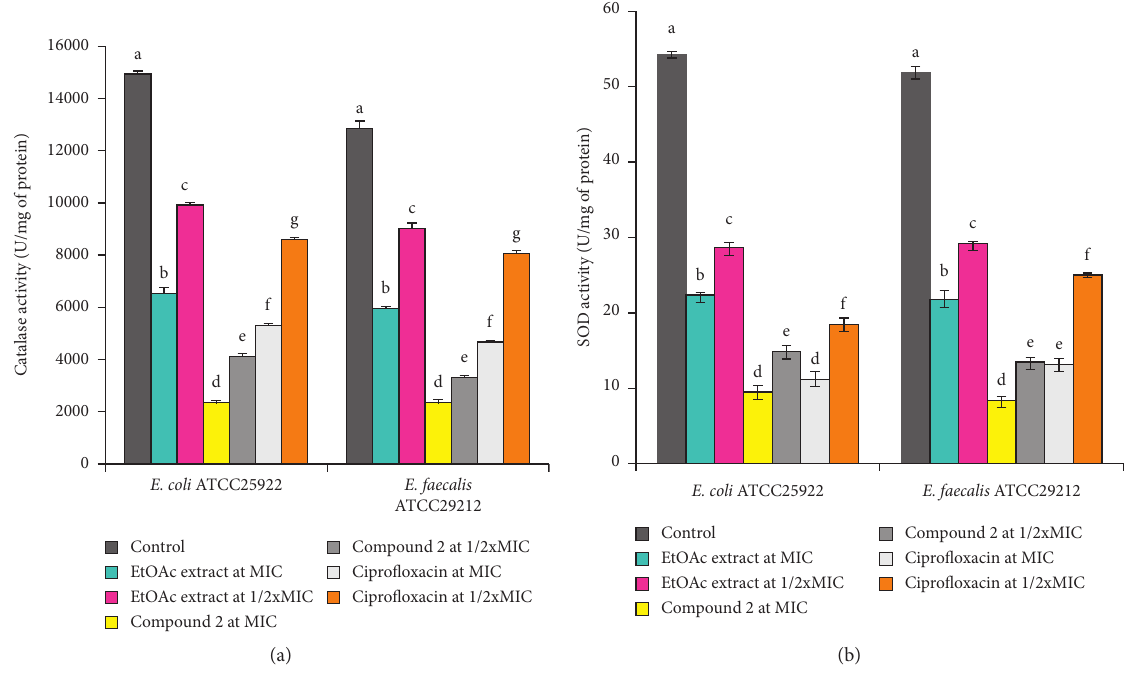
Figure 3: Antioxidant catalase (a) and superoxide dismutase (b) activities in E. coli and E. faecalis treated with EtOAc extract and compound 2. Bars represent the mean ± SD of three independent experiments carried out in triplicate. For the same bacteria and enzyme, values earmarked by different superscript letters (a–f) are significantly different according to one-way ANOVA and Waller-Duncan test; p < 0 . 05.